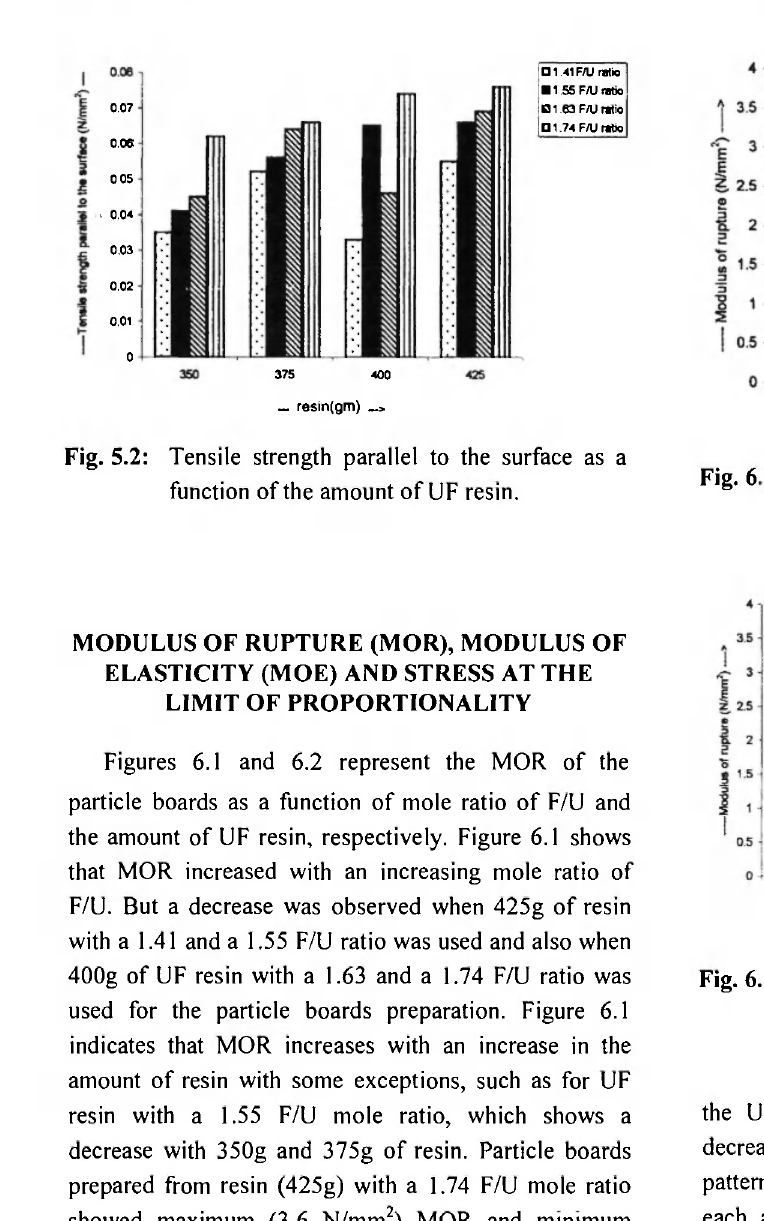
Fig. 6.2: Modulus of rupture as a function of the amount of UF